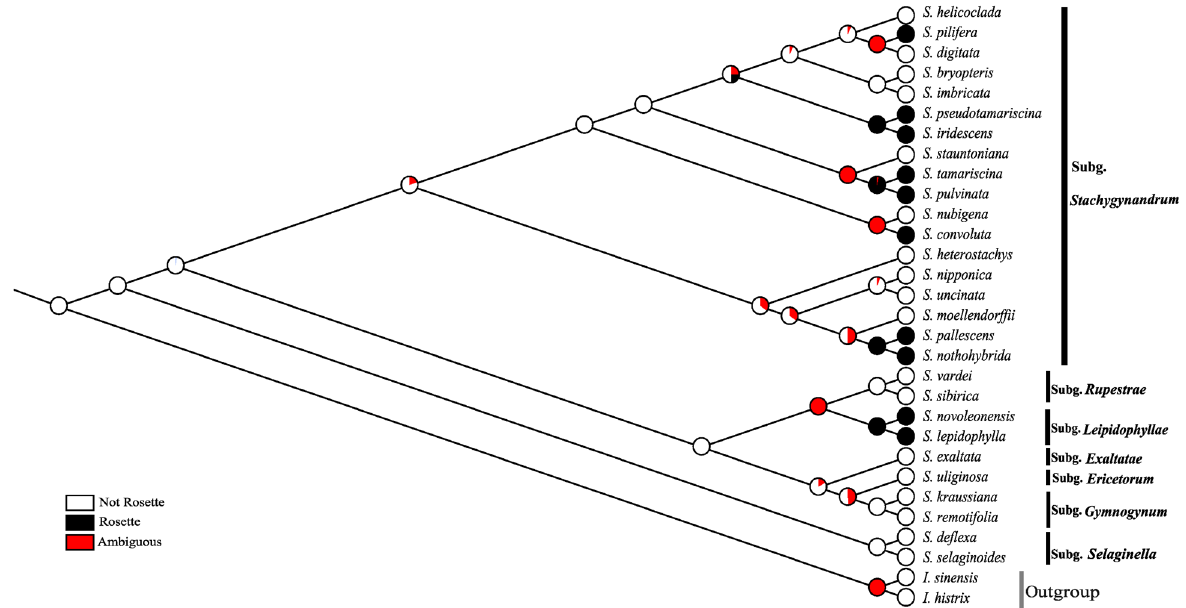
Figure 6. The inferred ancestral states for rosette habit based on the Mk1 model. Black and white in the pie charts on each branch indicate the probabilities of ancestral states inferred by the analysis based on the 1000 RAxML bootstrap